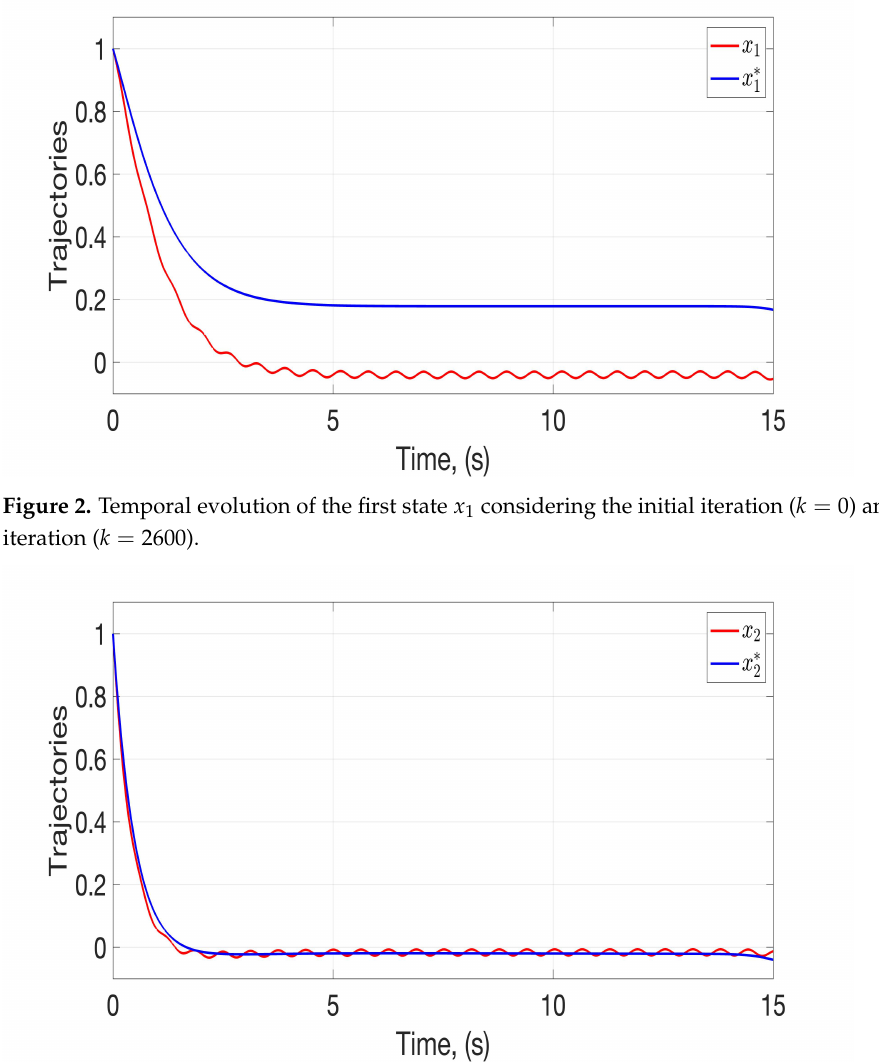
Figure 3. Temporal evolution of the second state x 2 considering the initial iteration ( k = 0) and the final iteration ( k =